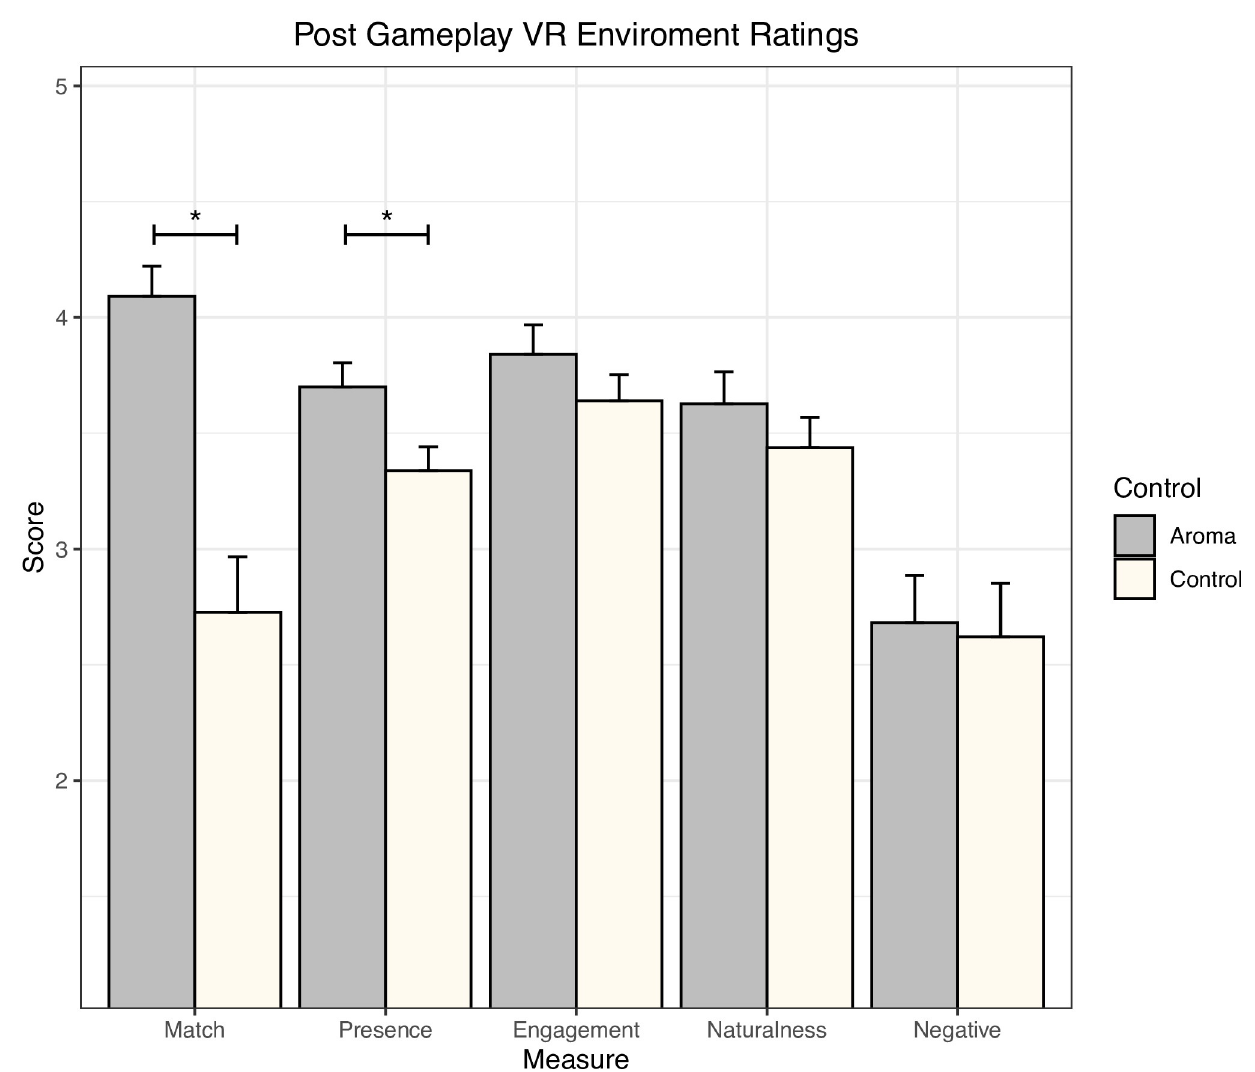
Fig 2. Comparison of ITC-SOPI scores (SEM) post VR gameplay with and without the presence of odour. � p < 0.05.